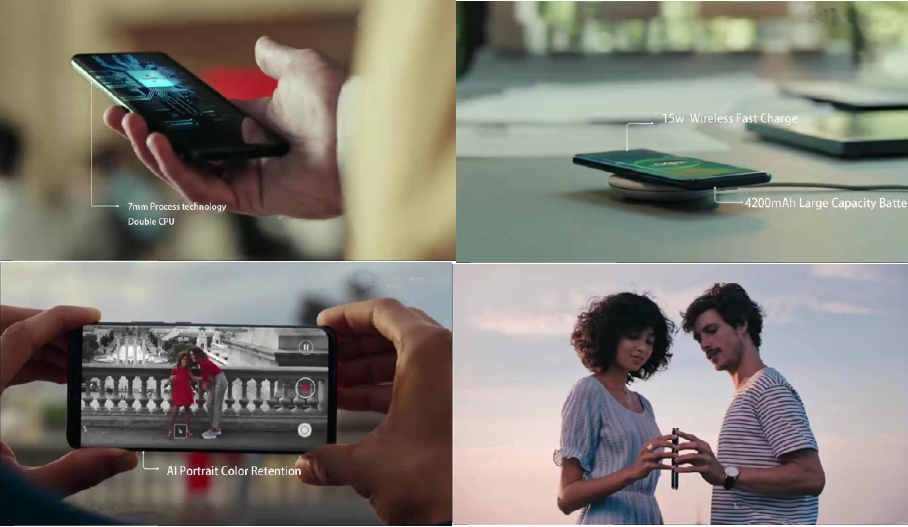
Figure 5. Example of usage scenario information.